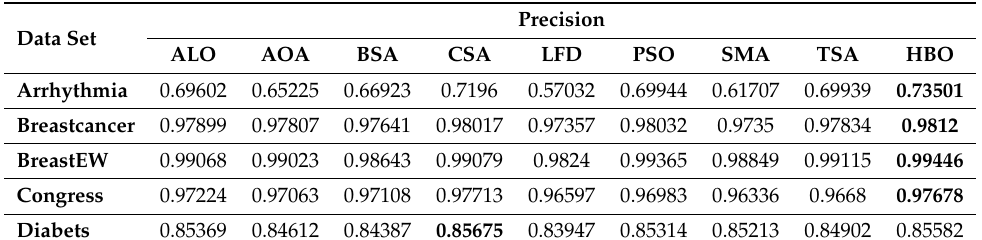
Table 6. The average Precision of B_HBO against other recent